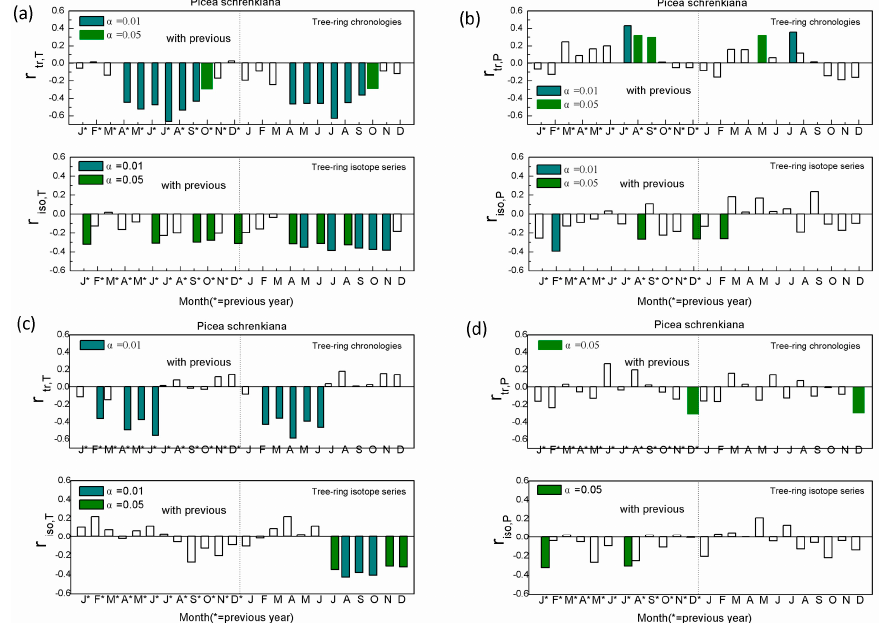
Figure 6. ( a ) Correlation coefficient of the lagged monthly temperature with the Ili TRW chronologies and isotope series. ( b ) Correlation coefficient of the lagged monthly precipitation with the Ili TRW chronologies and isotope series. ( c ) Correlation coefficient of the lagged monthly temperature with the Manas TRW chronologies and isotope series. ( d ) Correlation coefficient of the delayed monthly precipitation with the Manas TRW chronologies and isotope series.